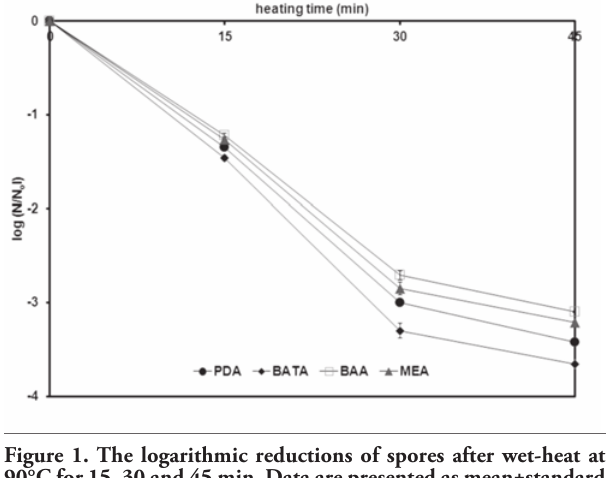
Figure 1. The logarithmic reductions of spores after wet-heat at 90°C for 15, 30 and 45 min. Data are presented as mean±standard deviation (n=3).